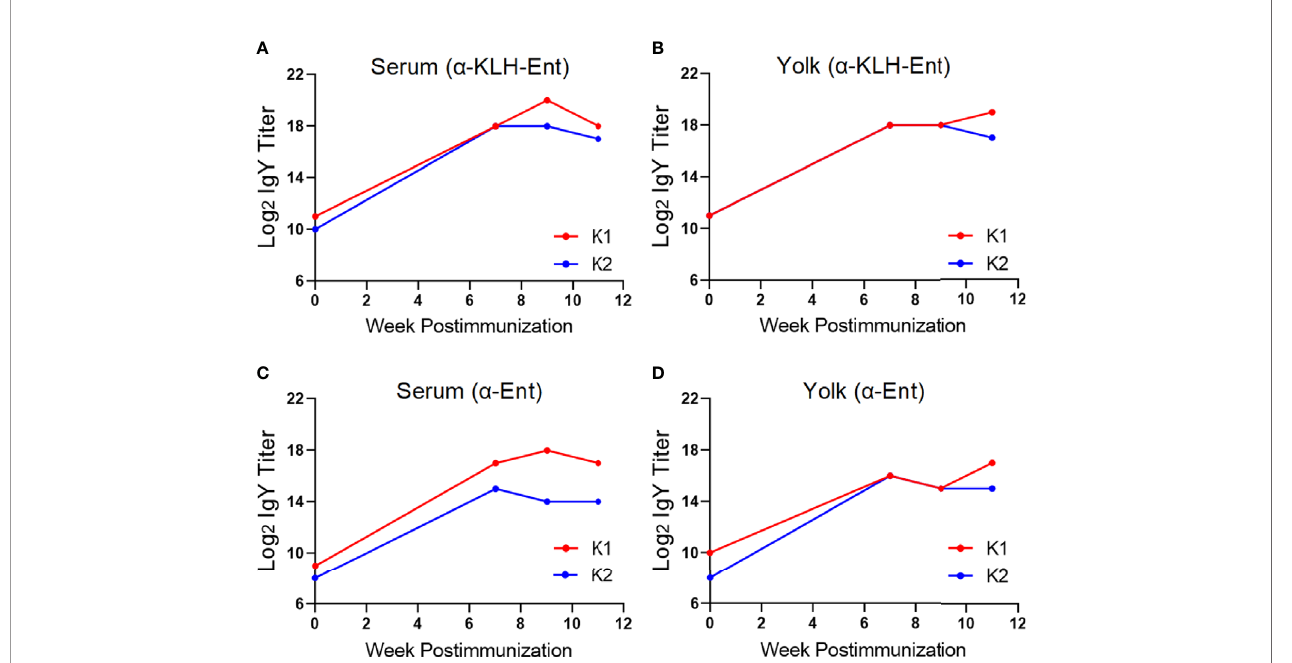
FIGURE 3 | Immune response of Rhode Island Red layers upon subcutaneous immunization with the KLH-Ent conjugate (Trial #2). (A) Serum IgY titer against the KLH-Ent conjugate. (B) Egg yolk IgY titer against the KLH-Ent conjugate. (C) Serum IgY titer against Ent molecule. (D) Egg yolk IgY titer against Ent molecule. Each point represents mean IgY titer from duplicate measurements within single chicken. K1 and K2 denote the two individual chickens immunized with KLH-Ent.